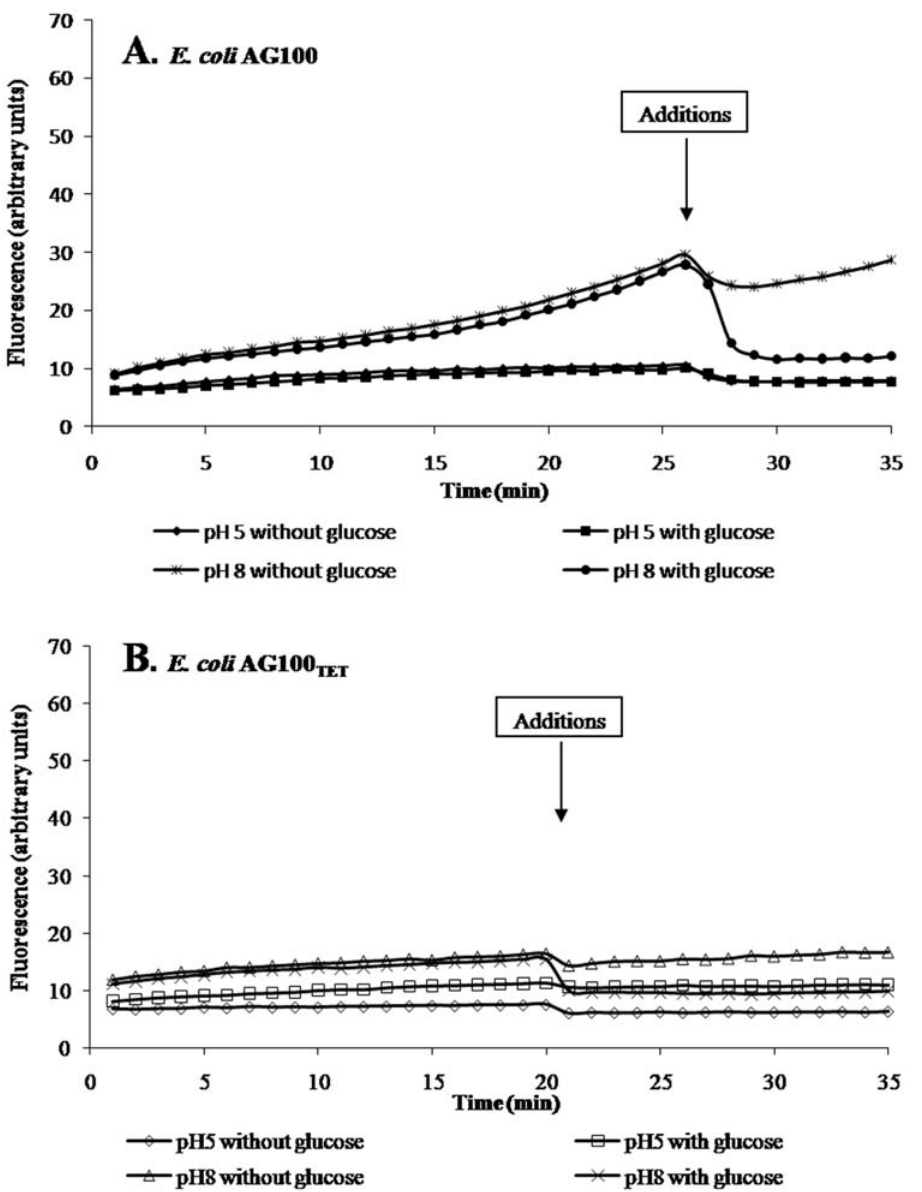
Figure 2. The effect of pH and the need for metabolic energy for efflux of EB by E.coli AG100 (Fig. 2A) and AG100 TET (Fig. 2B). Accumulation of EB in glucose-free saline at pHV5 and 8 for 25 minutes. Instrument is stopped and glucose-free and glucose-saline pHV5 and 8, respectively, is added and the instrument restarted. A slight drop of recording takes place when the instrument is stopped and when restarted measurement of fluorescence continues. Note. Whereas the addition of glucose-saline at pH 8 to the tube containing glucose-free saline at pH 8 causes an immediate drop of fluorescence, the addition of glucose-free medium does not, and the slope representing the increase of fluorescence remains equal to that exhibited during accumulation in glucose-free saline at pH 8. Accumulation of EB in glucose-free saline at pH 5 is minimal (just above background) and remains unaltered with the addition of either glucose-free or glucose-saline at pH 5.